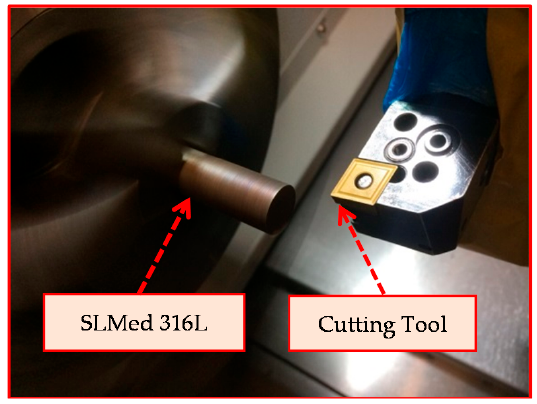
Figure 2. Experimental photography.